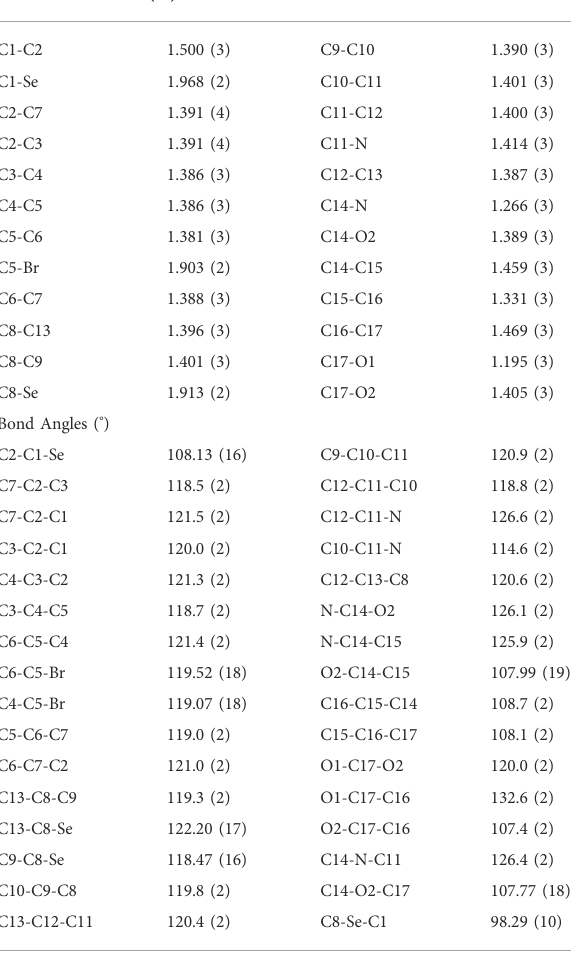
TABLE 2 Selected bond distances and angles of isomaleimide